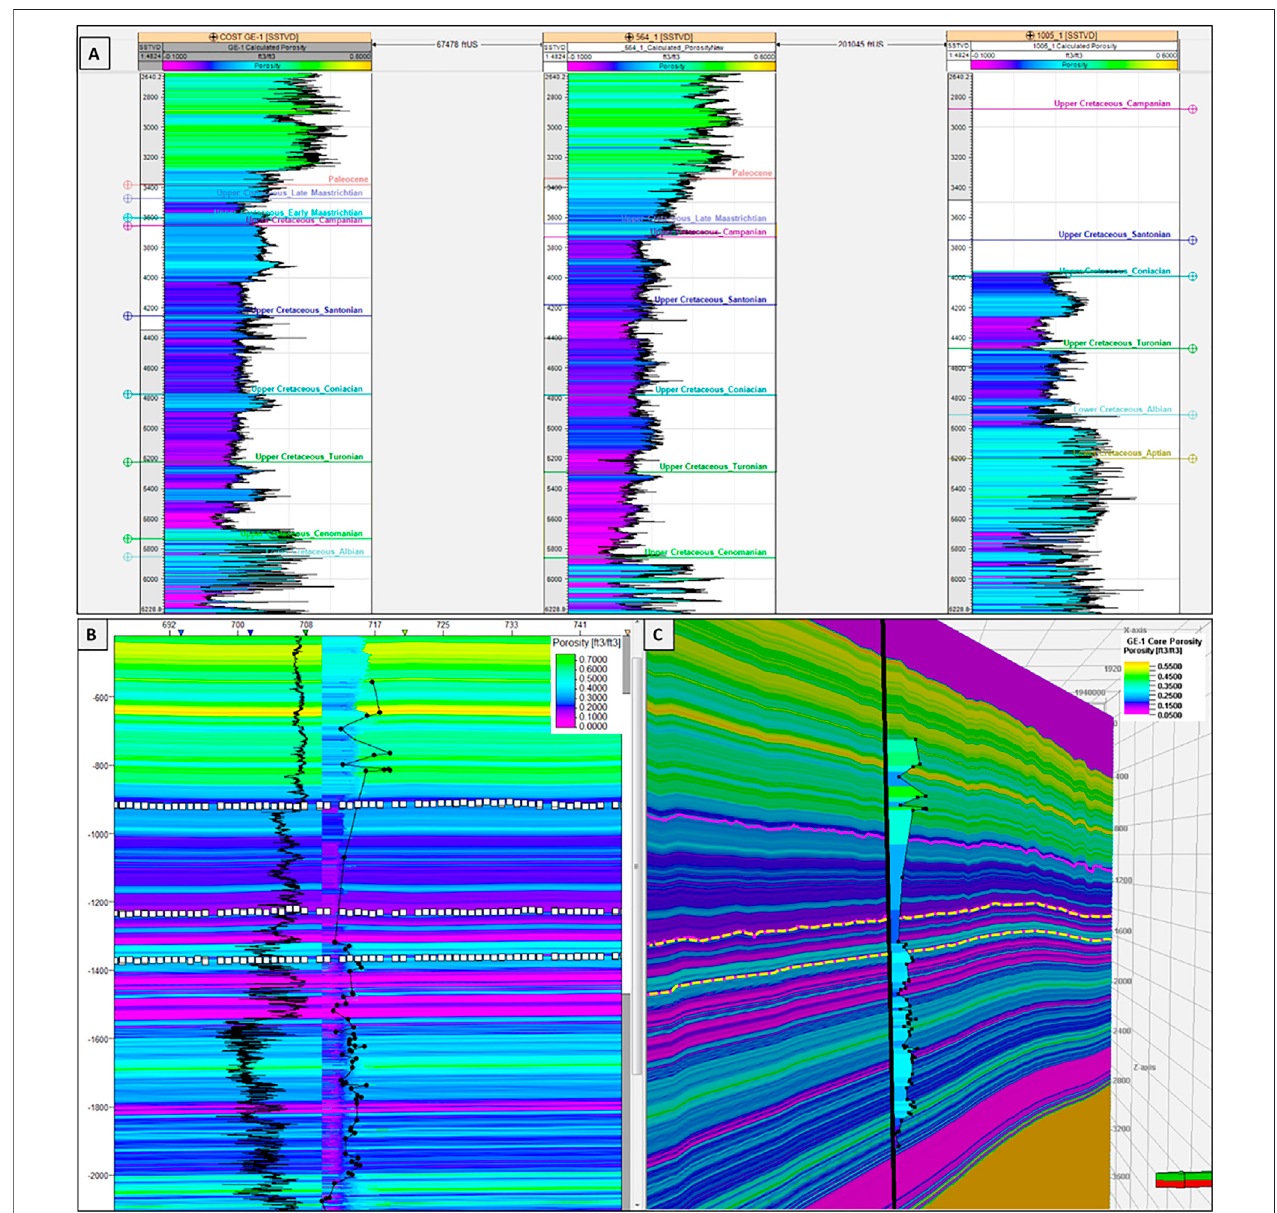
FIGURE 7 | (A) Calculated porosity logs at COST GE-1, Exxon 564-1, and Transco 1005-1 wells. (B) Extrapolated porosity using inversion property builder at the well GE-1.